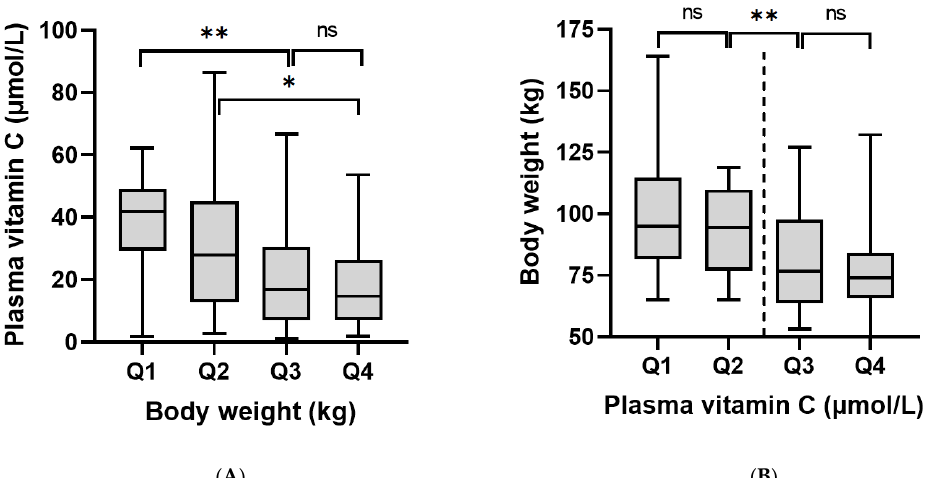
Figure 4. Relationships between vitamin C concentrations and body weight: ( A ) body weight quartiles: Q1 = 50–71 kg, Q2 = 72–84 kg, Q3 = 85–105 kg, Q4 = 106–164 kg (ANOVA p = 0.0001). ( B ) Vitamin C quartiles: Q1 = 1–12 µmol/L, Q2 = 13–22 µmol/L, Q3 = 23–42 µmol/L, Q4 = 42–87 µmol/L (ANOVA p < 0.001). * p < 0.05, ** p < 0.01. Dashed line indicates 23 µmol/L cut-off. Body weight was significantly different either side of this cut-off ( p < 0.0001). Multivariable analysis of potential predictors of vitamin C status identified weight